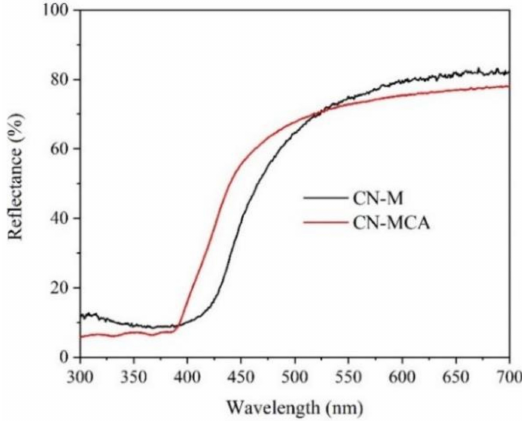
Figure 1. UV–Vis DR spectra of graphitic carbon nitride (CN) materials.